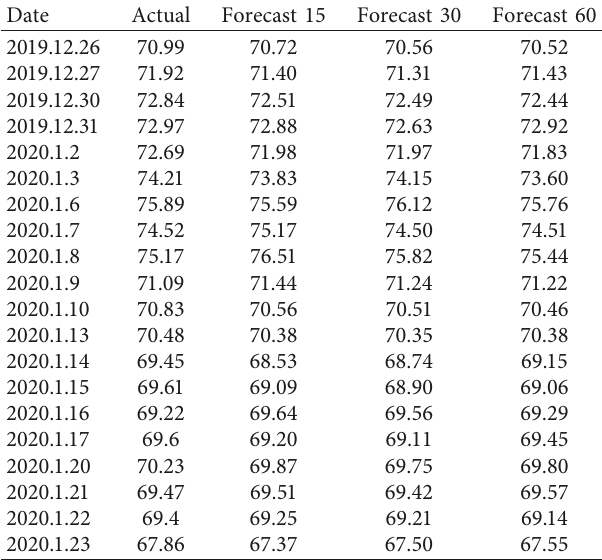
Table 2: Actual and forecast price (USD per barrel) in different frequencies with night trading (before February, 2020).